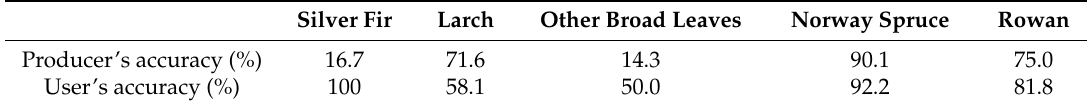
Table 3. Producer’s and user’s accuracies of tree species classification at the ITC level. Silver Fir Larch Other Broad Leaves Norway Spruce